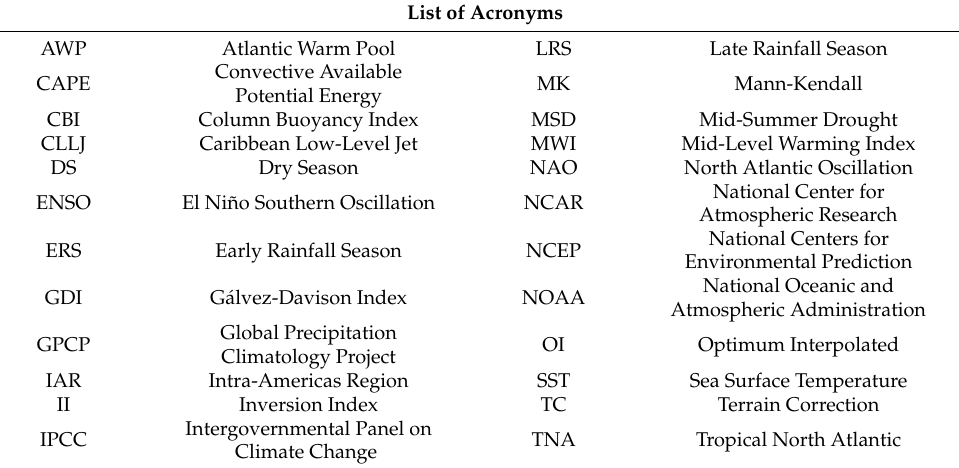
Table 1. List of